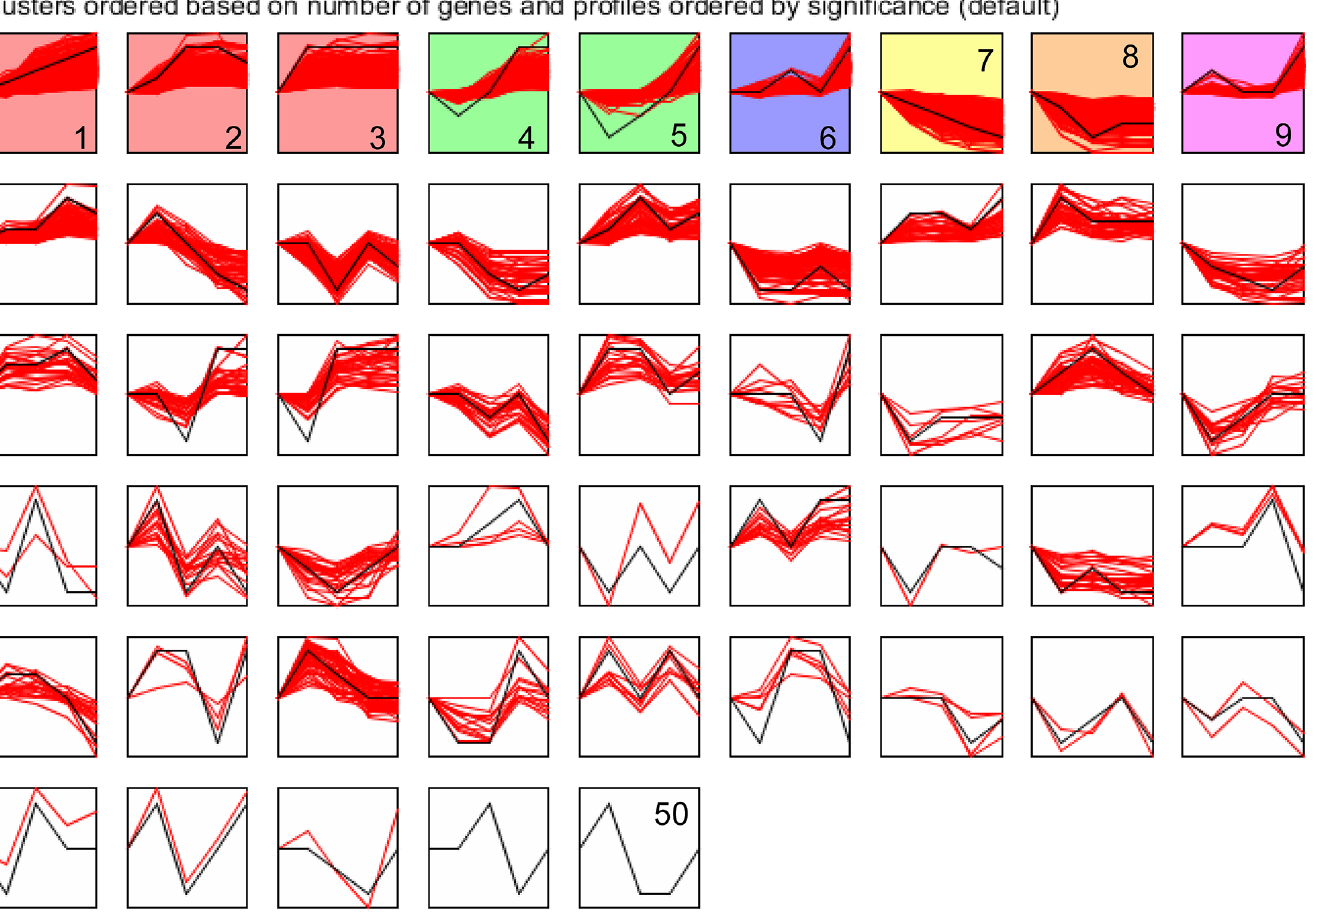
Fig 3. Expression profile and clusters of DEGs obtained from the STEM clustering. Numbers indicated clusters or profiles. Clusters were ordered according to the number of genes while profiles were ordered according to significance. Significantly different profiles were represented by different background